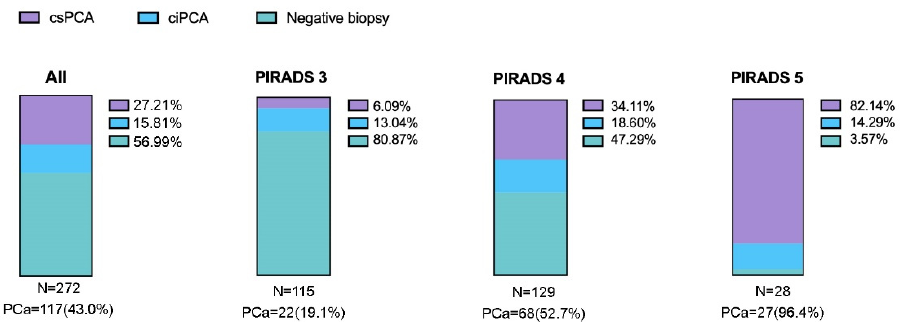
Figure 1. Percentages of patients with clinically significant (csPCa), insignificant (ciPCa), and no cancer in the whole cohort (leftmost bar chart) or according to PIRADS v2 score (remaining bar charts).